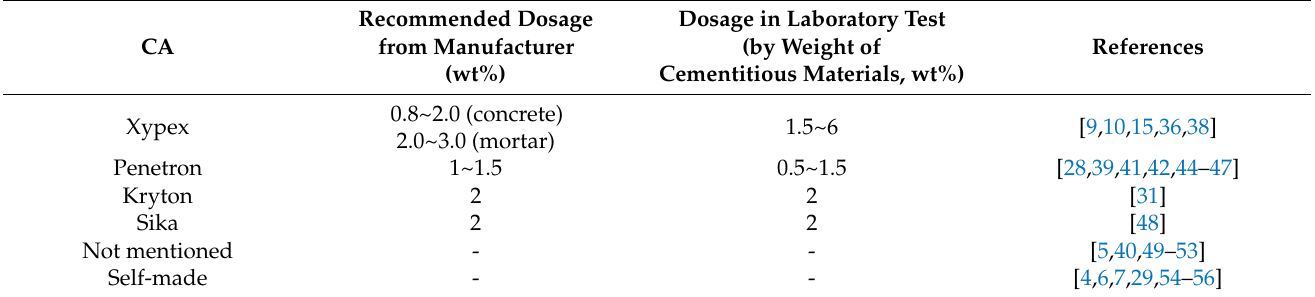
Table 1. Application of commercial CAs and self-made CAs in laboratory test.